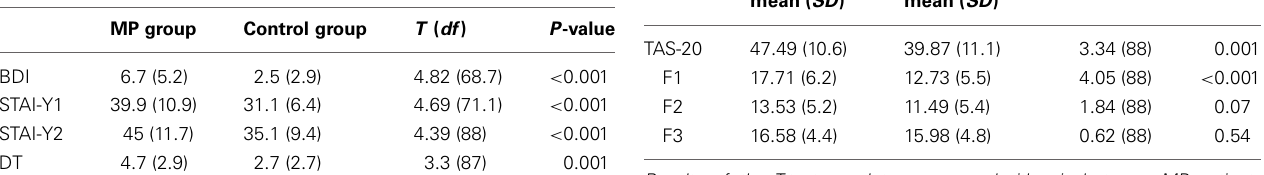
Table 2 | Psychological distress in myofascial pain (MP) group and control group.